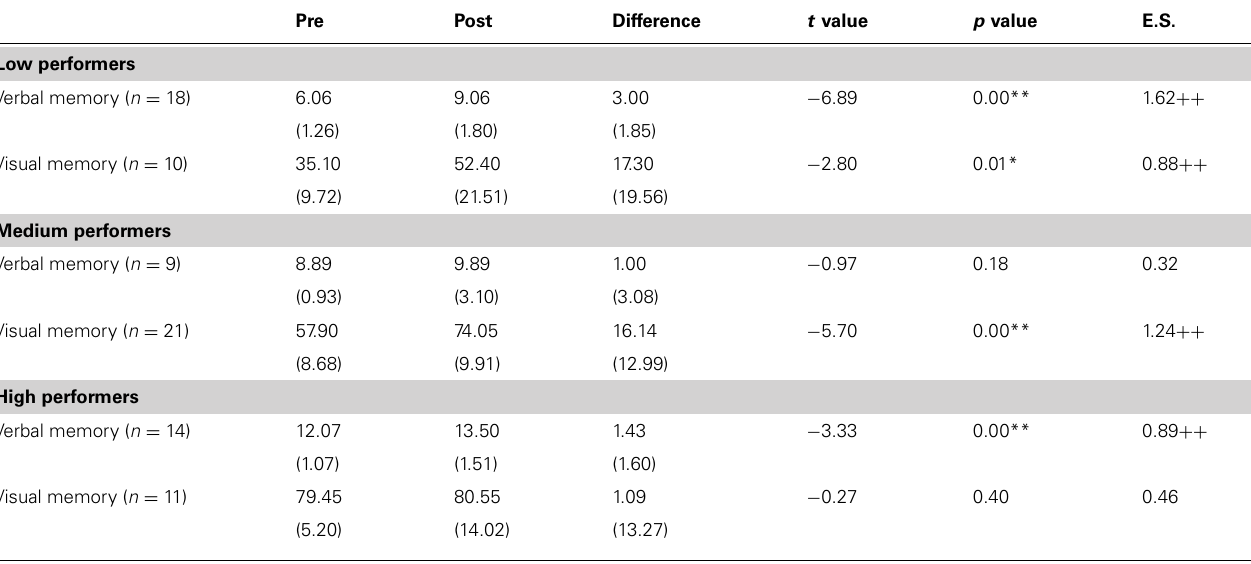
Table 2 | Memory performance of the three groups of performers at pre- and